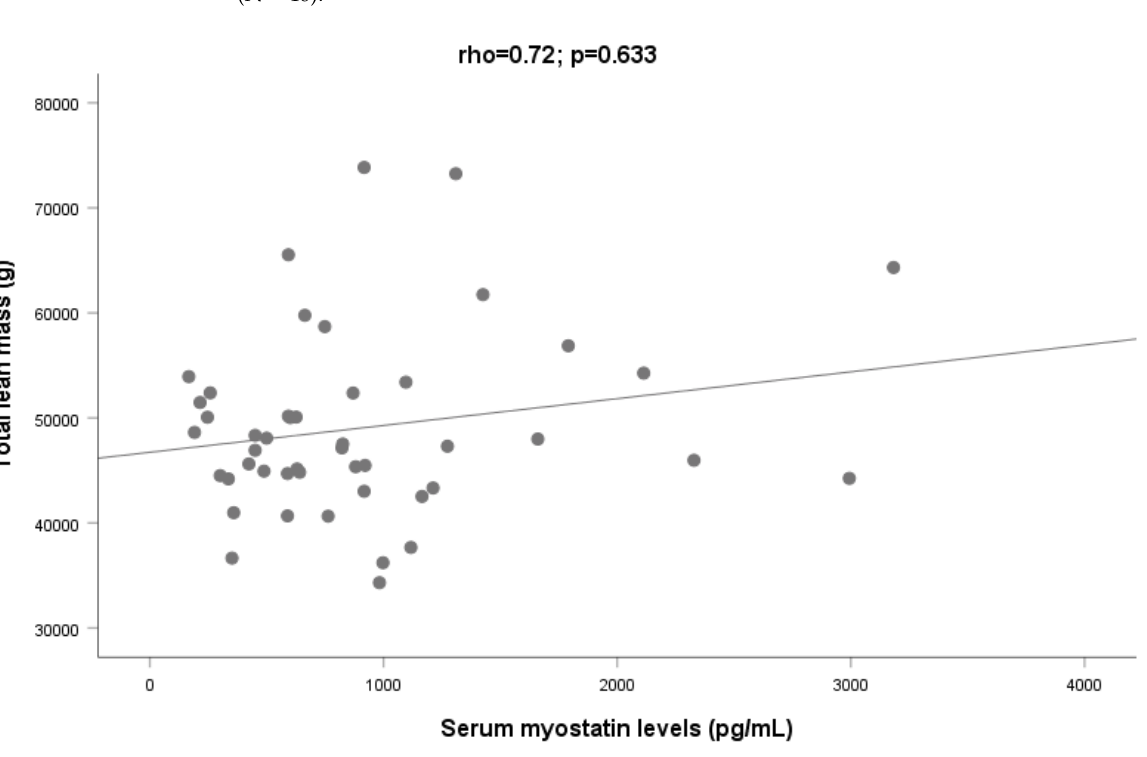
Figure 3. Relationship between serum myostatin and total lean mass among patients (N = 46).